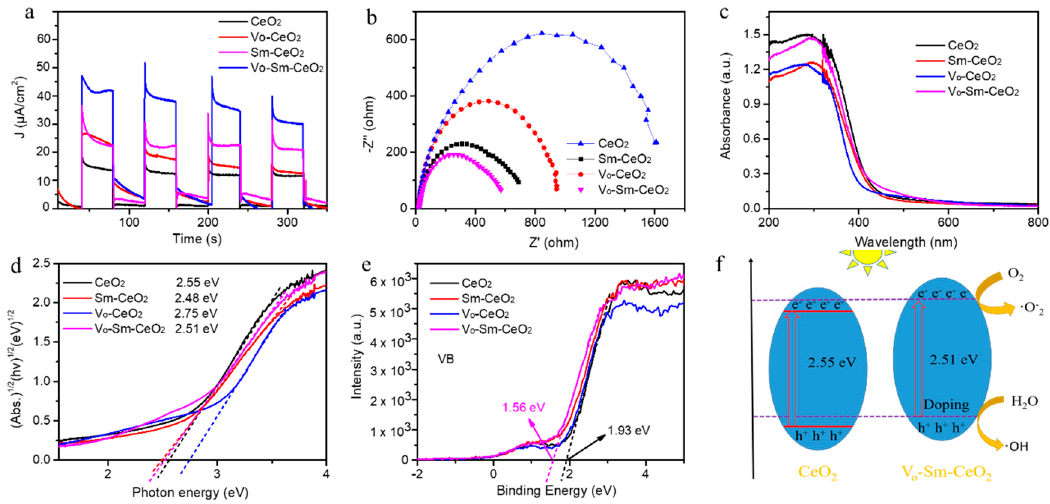
Figure 6. ( a ) Transient photocurrent responses, ( b ) electrochemical impedance spectra (applied potential 0.1 eV), ( c ) UV–Vis spectra, ( d ) optical band gaps, ( e ) VB spectra from XPS of CeO 2 , Sm–CeO 2 , Vo–CeO 2 , and Vo–Sm–CeO 2 . ( f ) Schematic for the proposed mechanism.